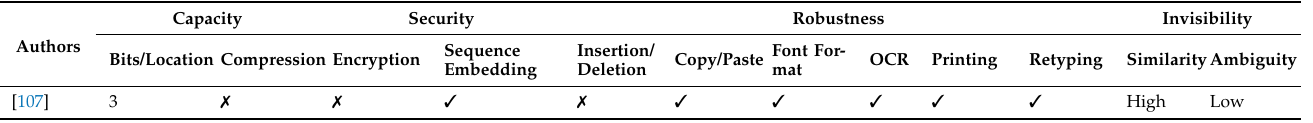
Table 25. Evaluation of poetry system method based on invisibility and robustness and capacity.